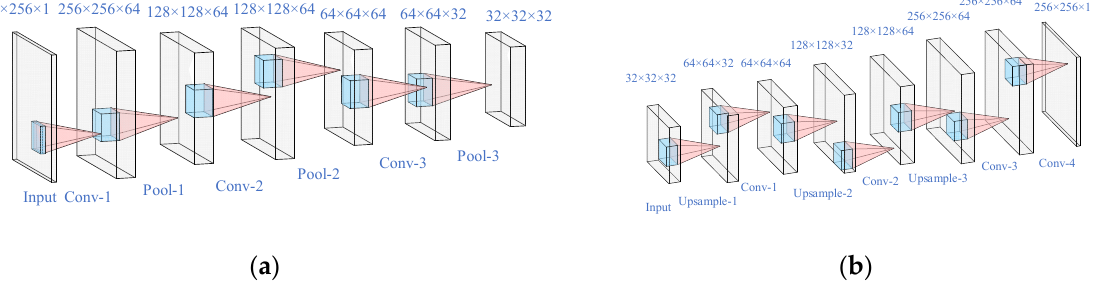
Figure 6. The architecture of discriminator. ( a ) is the structure of encoder. ( b ) is the structure of